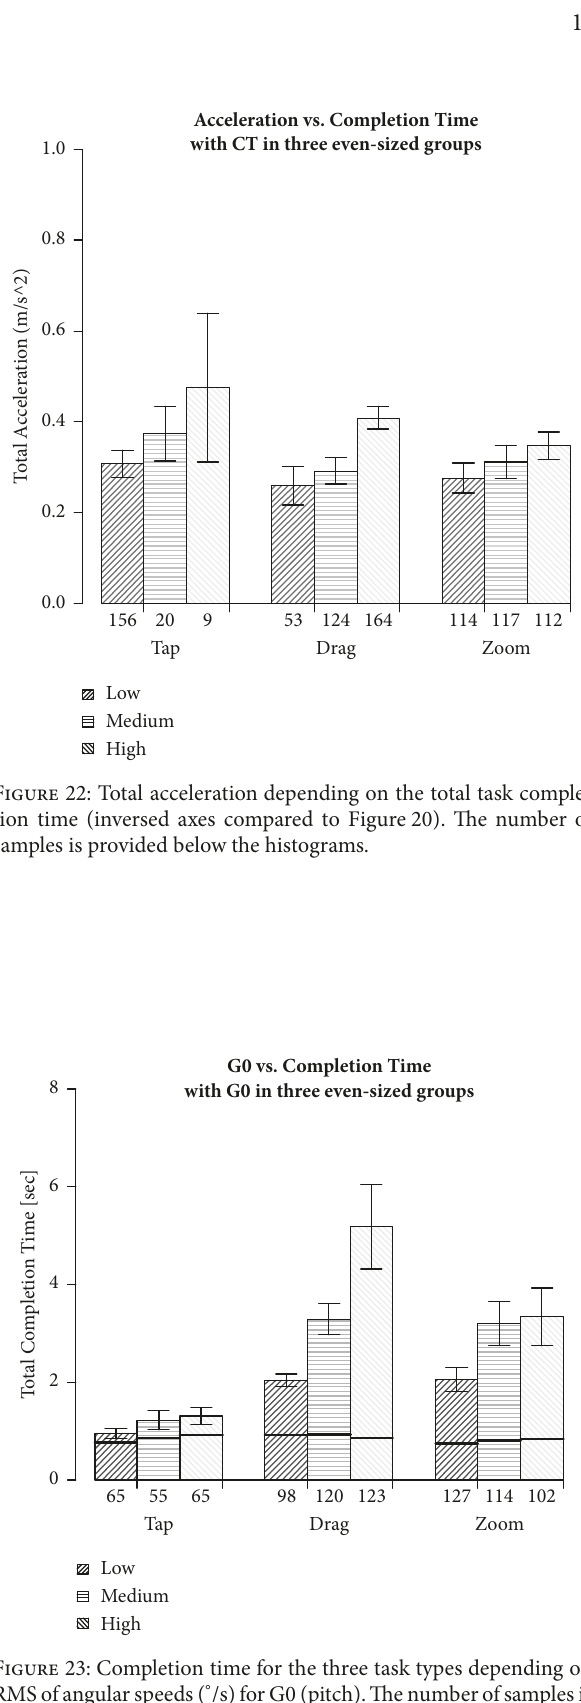
Figure 21: Number of errors for the three task types depending on RMS of acceleration intensity. The number of samples is provided below the histograms.